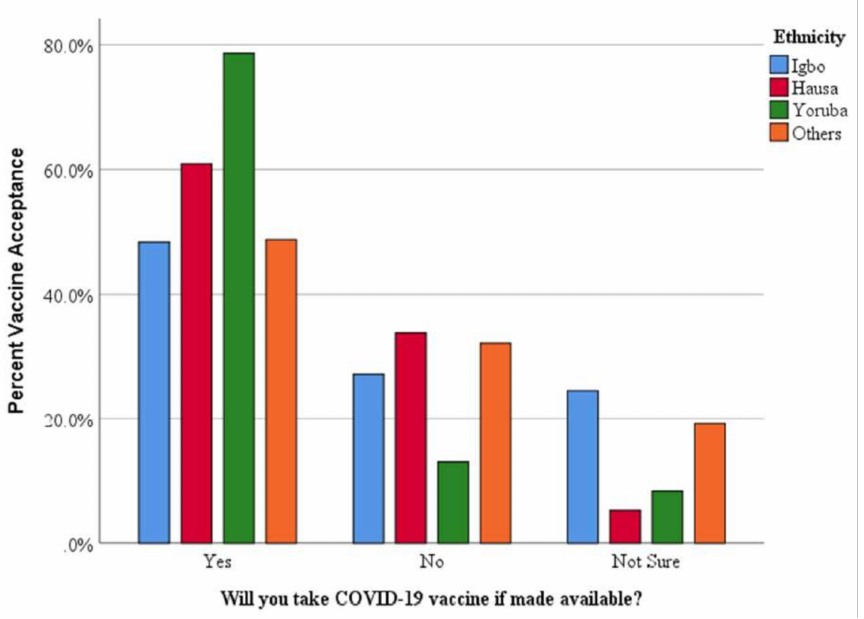
Figure 3. Vaccine acceptance across various ethnicities in